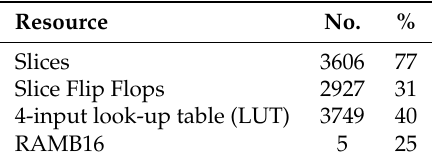
Table 5. Hardware NTP server resources utilization (Field programmable gate array (FPGA) Spartan-3E XC3S500E chip).